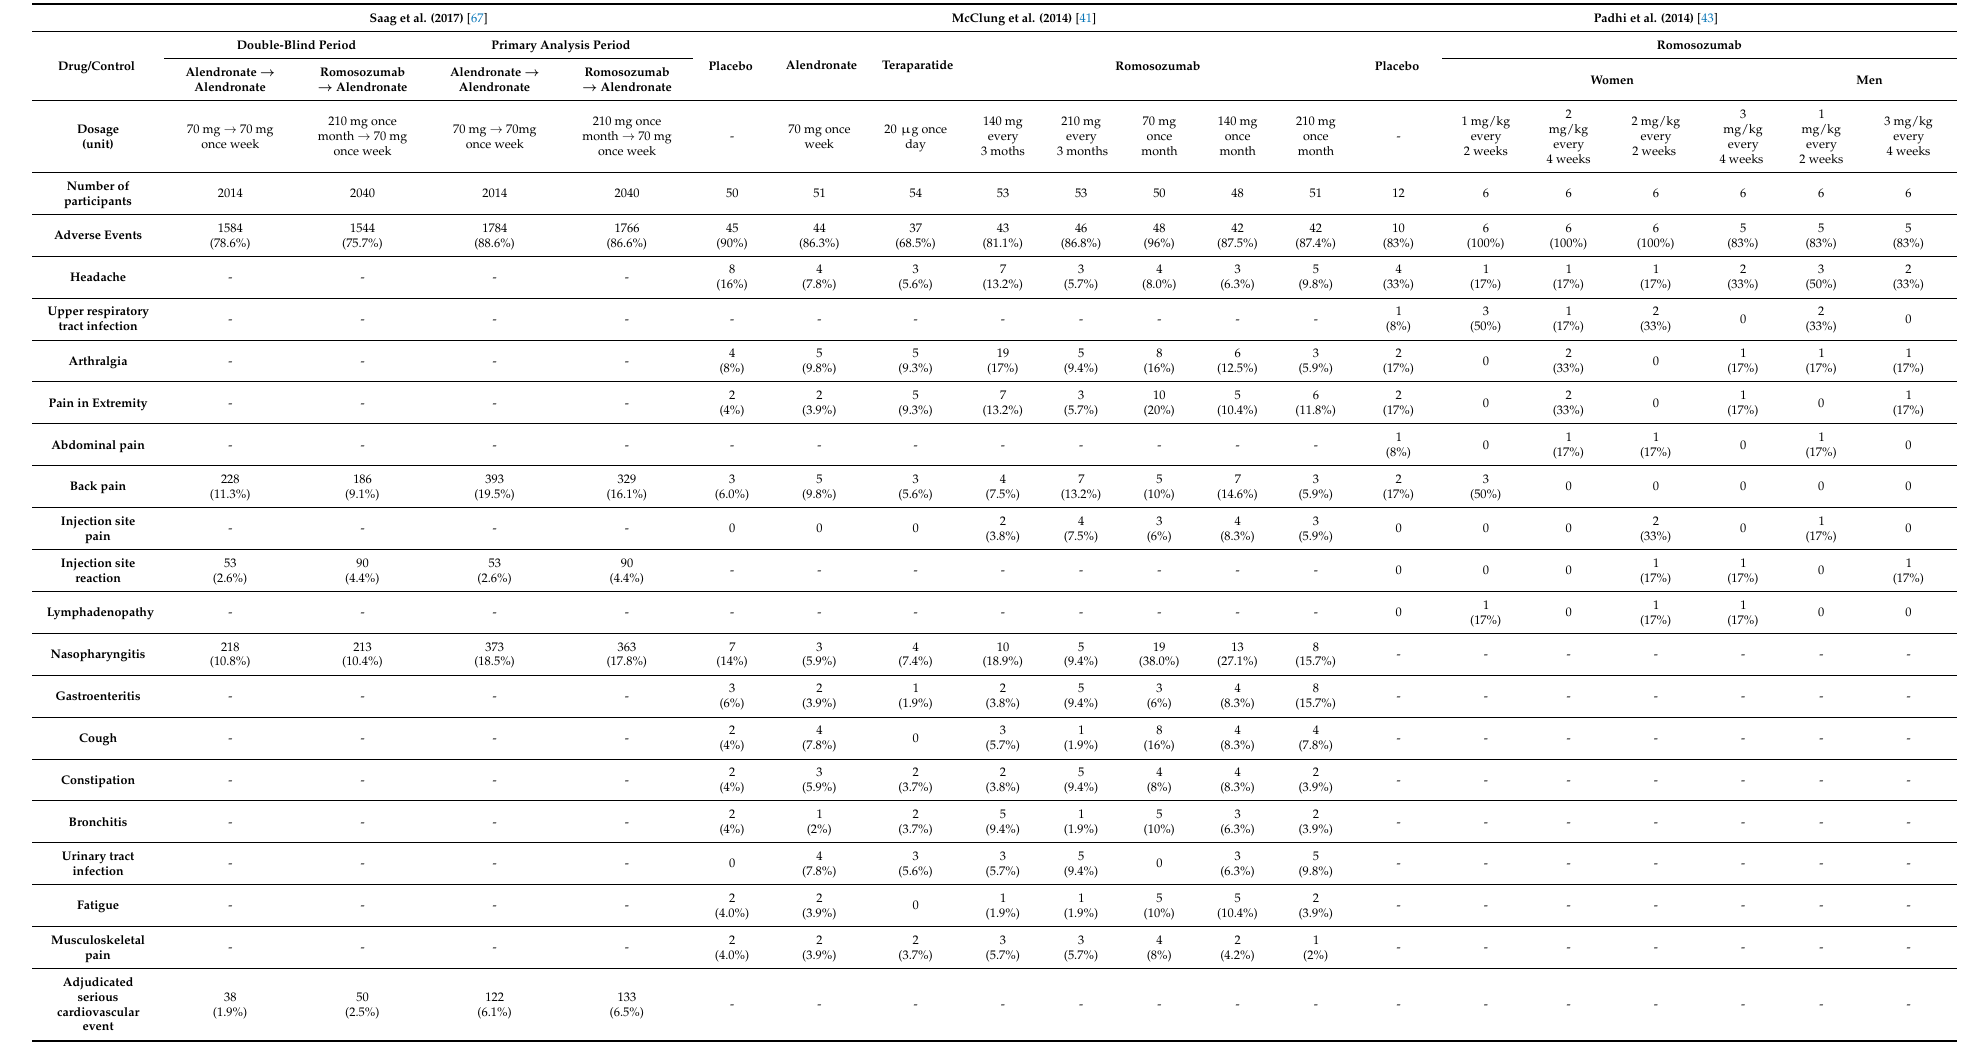
Table 3. Incidents